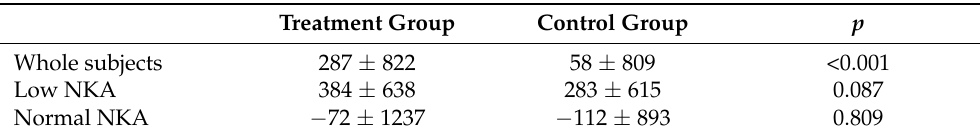
Table 3. Comparison of changes in IFN- γ levels from baseline to follow-up between the treatment and control